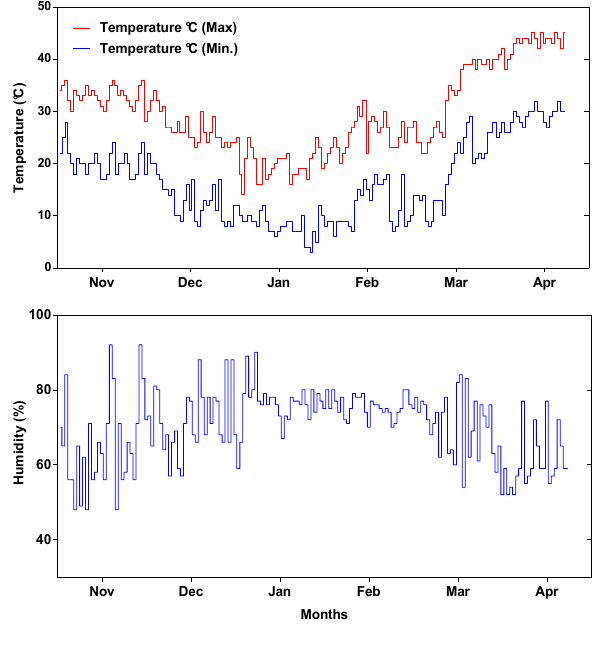
Figure 1 Weather conditions, including minimum–maximum temperature and humidity of the experimental field during the evaluation of 36 wheat genotypes in moisture stress (MS) and well-watered (WW) conditions.